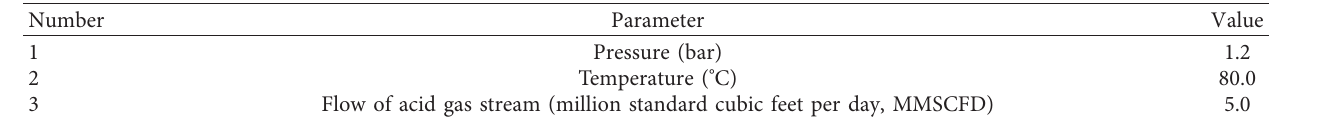
Table 2: Feed gas operating